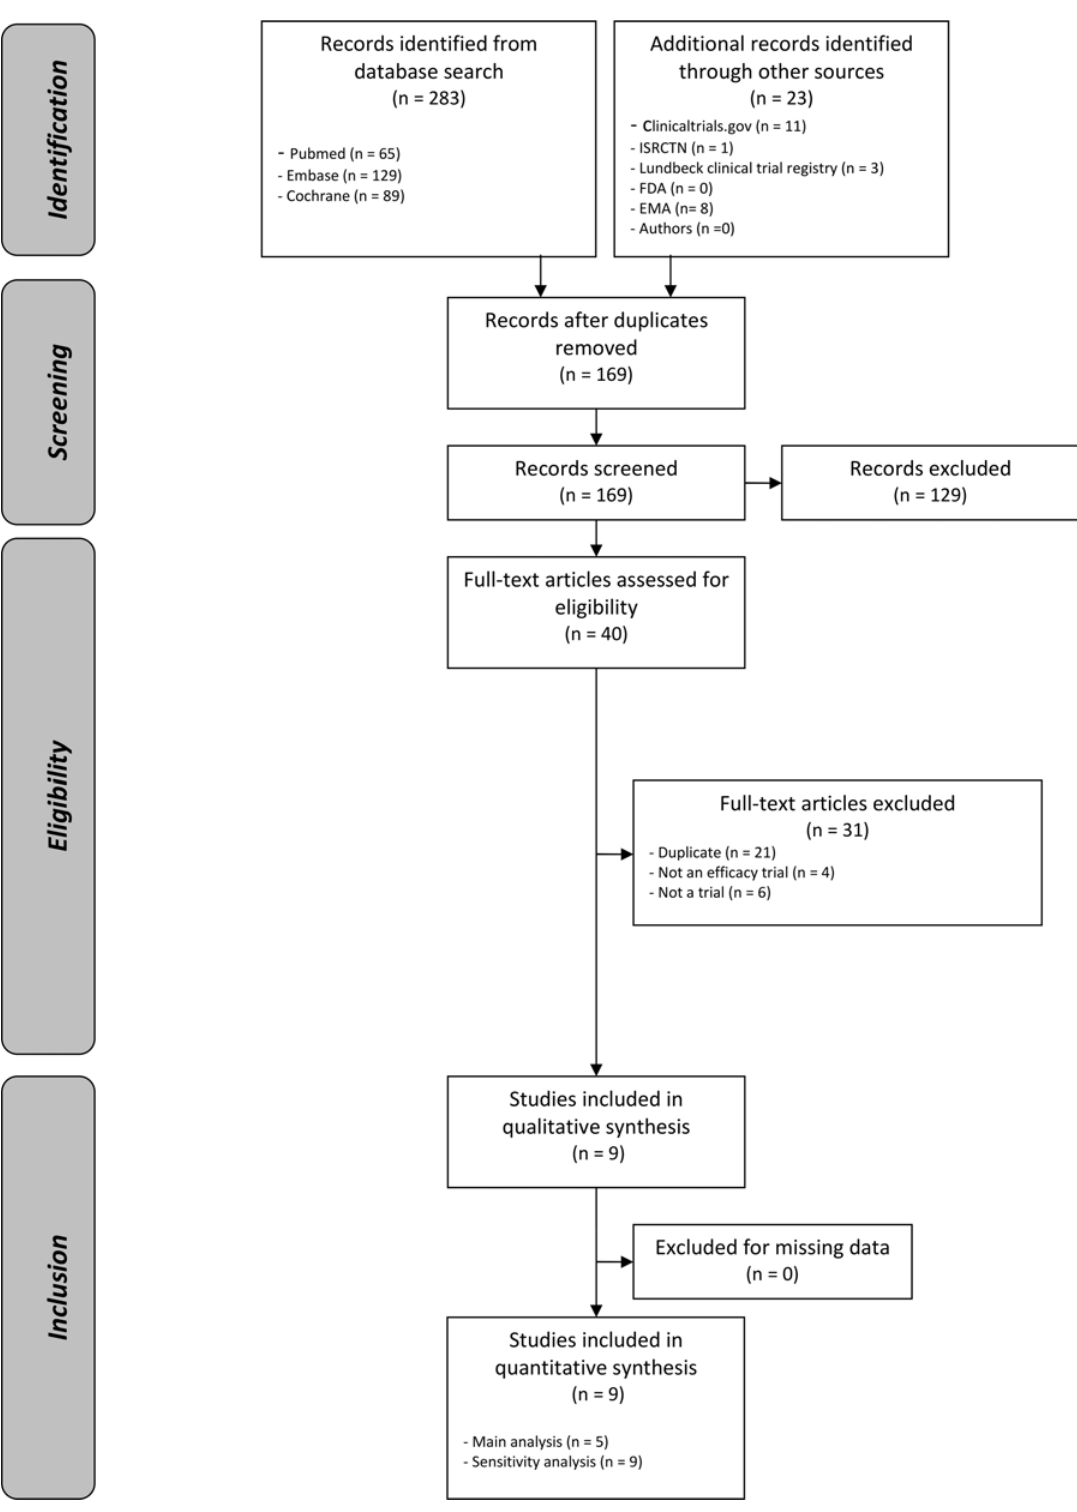
Fig 1. Flow diagram. FDA, US Food and Drug Administration.